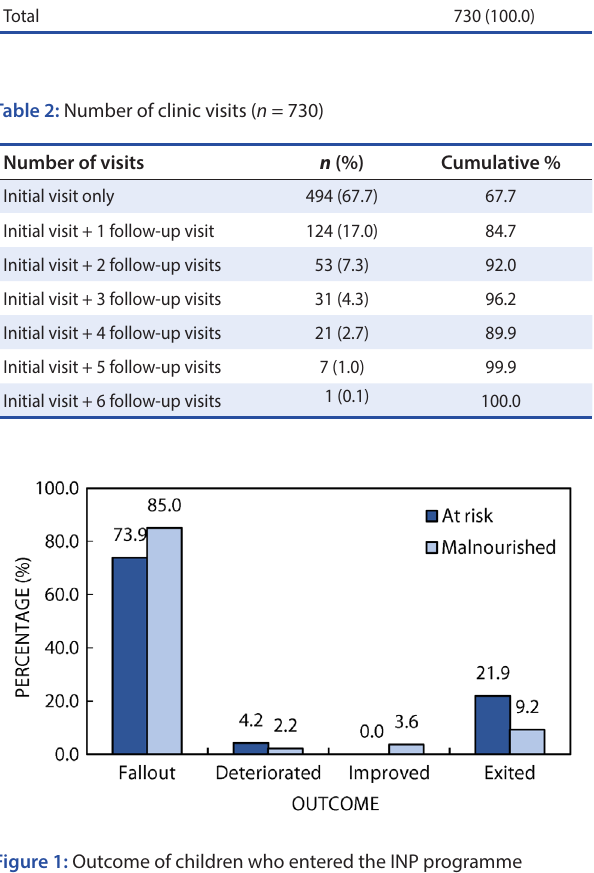
Figure 1: Outcome of children who entered the INP programme malnourished and at risk ( n = 730).